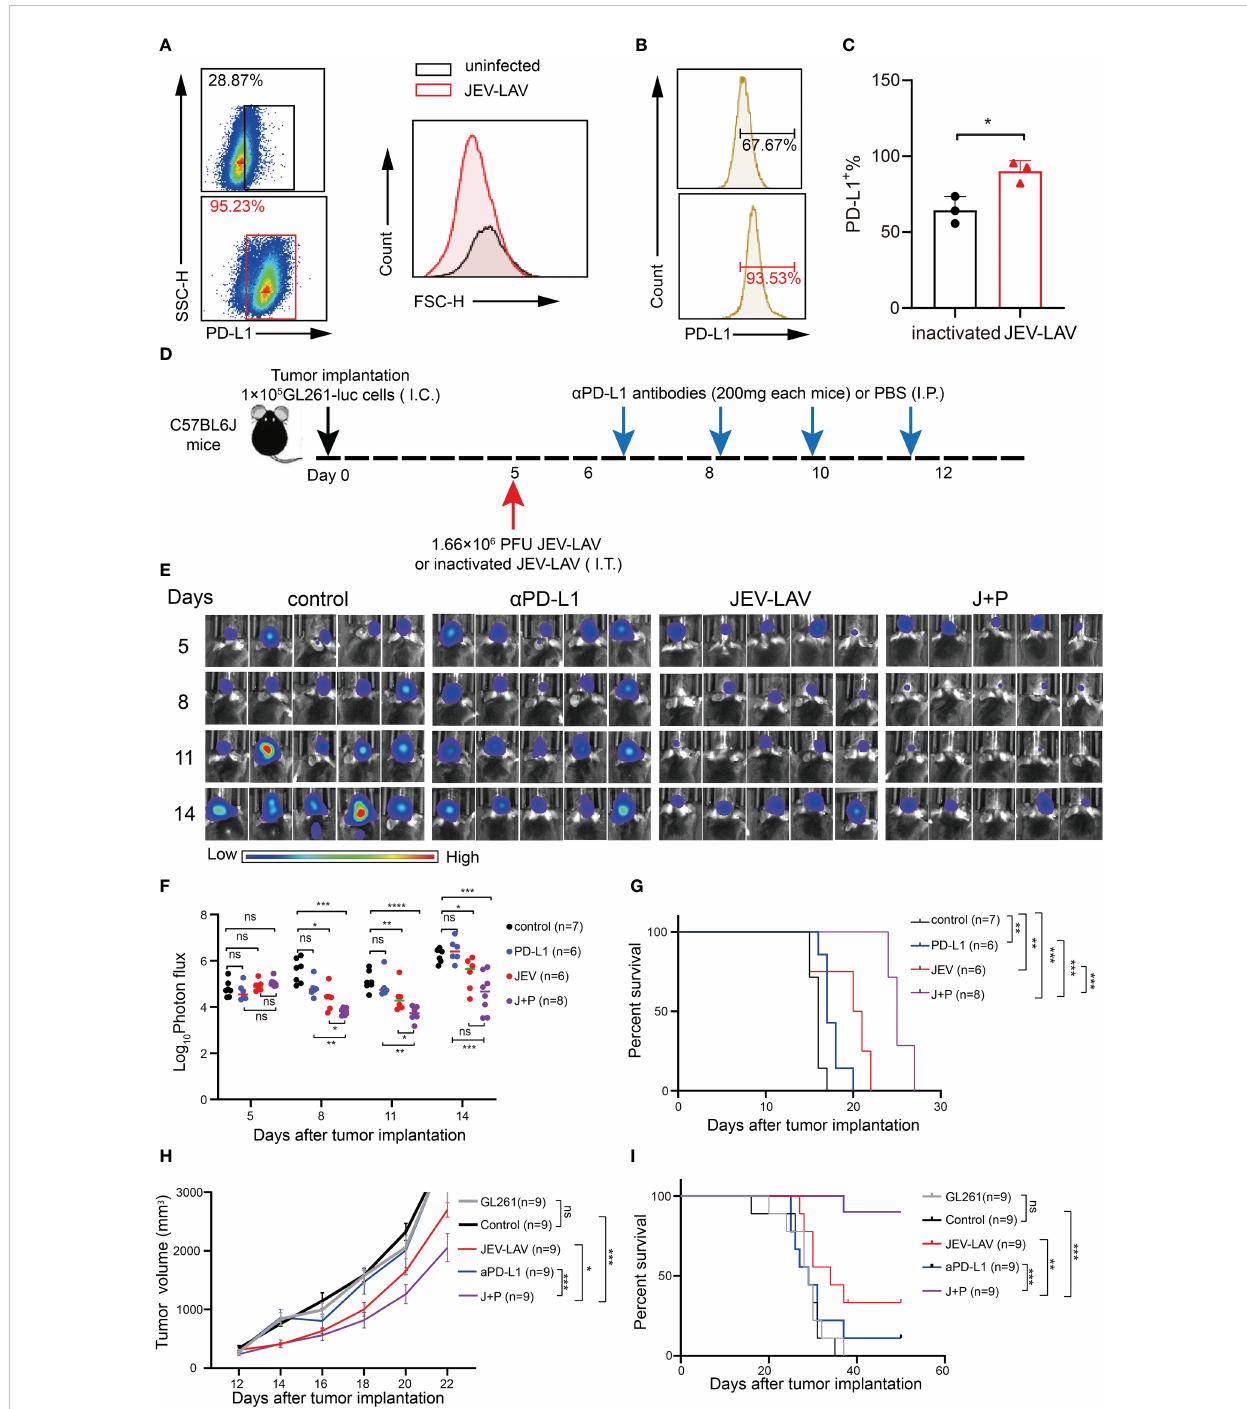
FIGURE 6 JEV-LAV therapy enhances the response of aPD-L1 blockade therapy. (A) The PD-L1 expression in GL261 cells infected with JEV-LAV in vitro . (B) PD-L1 expression in tumor cells in vivo after JEV-LAV treatment. (C) Percentage of PD-L1 + cells among the total cells isolated from the tumor. (D) Treatment schedule. C57BL/6J mice were intracranially implanted (I.C.) with 1 × 10 5 GL261-luc cells, injected intratumorally (I.T.) with 1.6 × 10 6 PFU JEV-LAV or inactivated JEV-LAV on day 5 and then injected intraperitoneally (I.P.) a PD-L1 antibodies (200 mg) on days 6, 8, 10, and 12. (E) Individual tumor growth via bioluminescence at the indicated time points. (F) Quanti fi cation of the total photon fl ux from each animal. (G) Survival. (H) Tumor volume. (I) Survival. *P<0.05, **P<0.01, ***P<0.001,****p<0.0001, ns no statistical signi fi